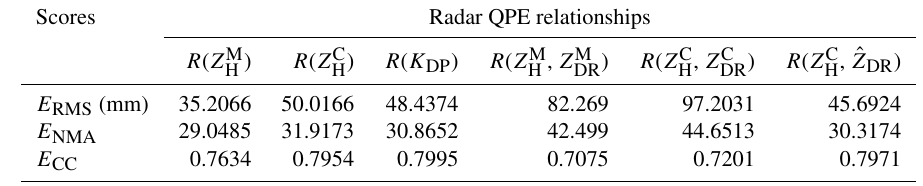
Table 1. Evaluation scores of 6h rainfall accumulations based on six radar QPE relationships.